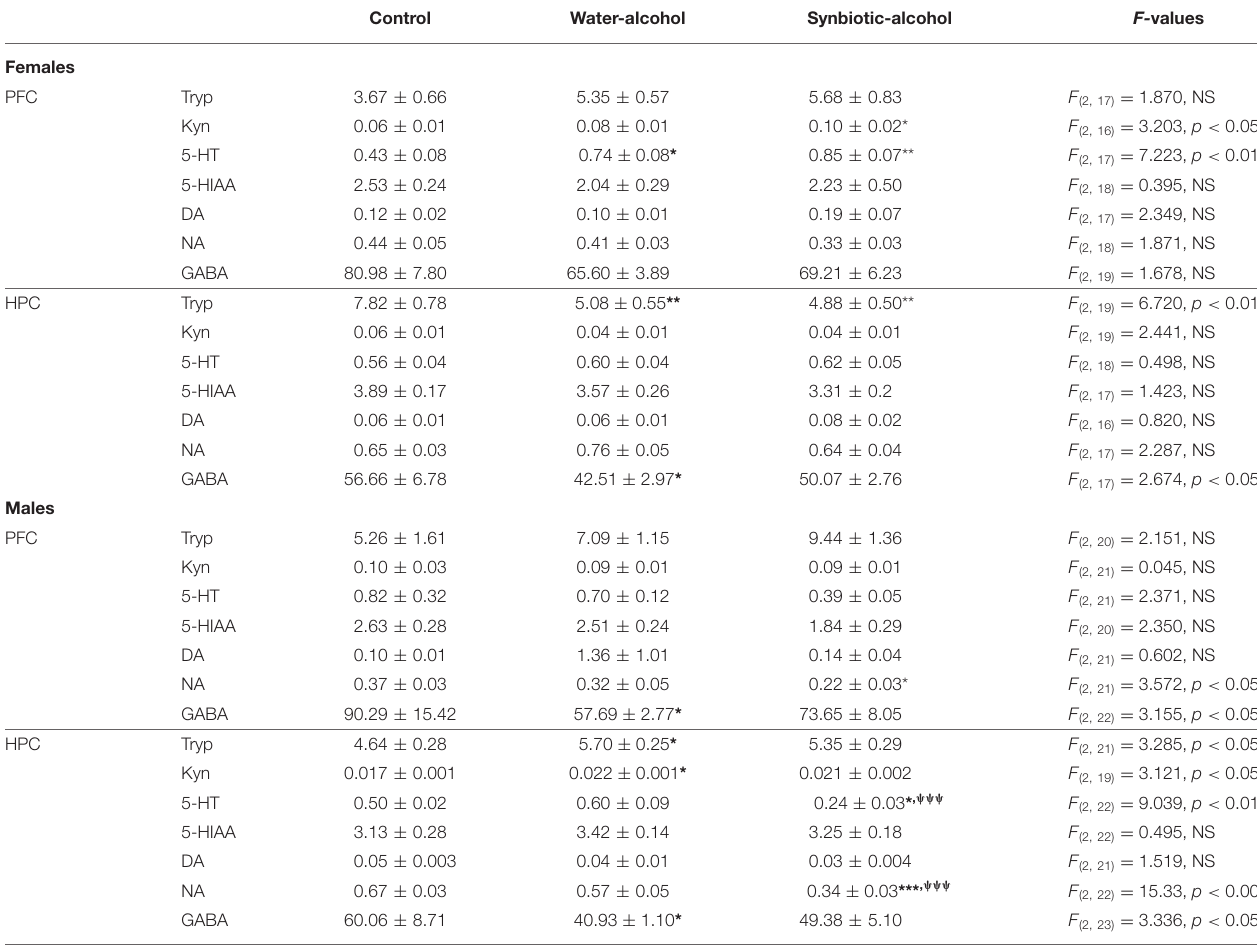
TABLE 2 | Tryptophan pathway metabolites and neurotransmitter concentrations in the prefrontal cortex (PFC) and hippocampus (HPC) of female and male mice following alcohol intake and concomitant exposure to water and synbiotic, and control mice exposed only to water (no alcohol). Control Water-alcohol Synbiotic-alcohol F-